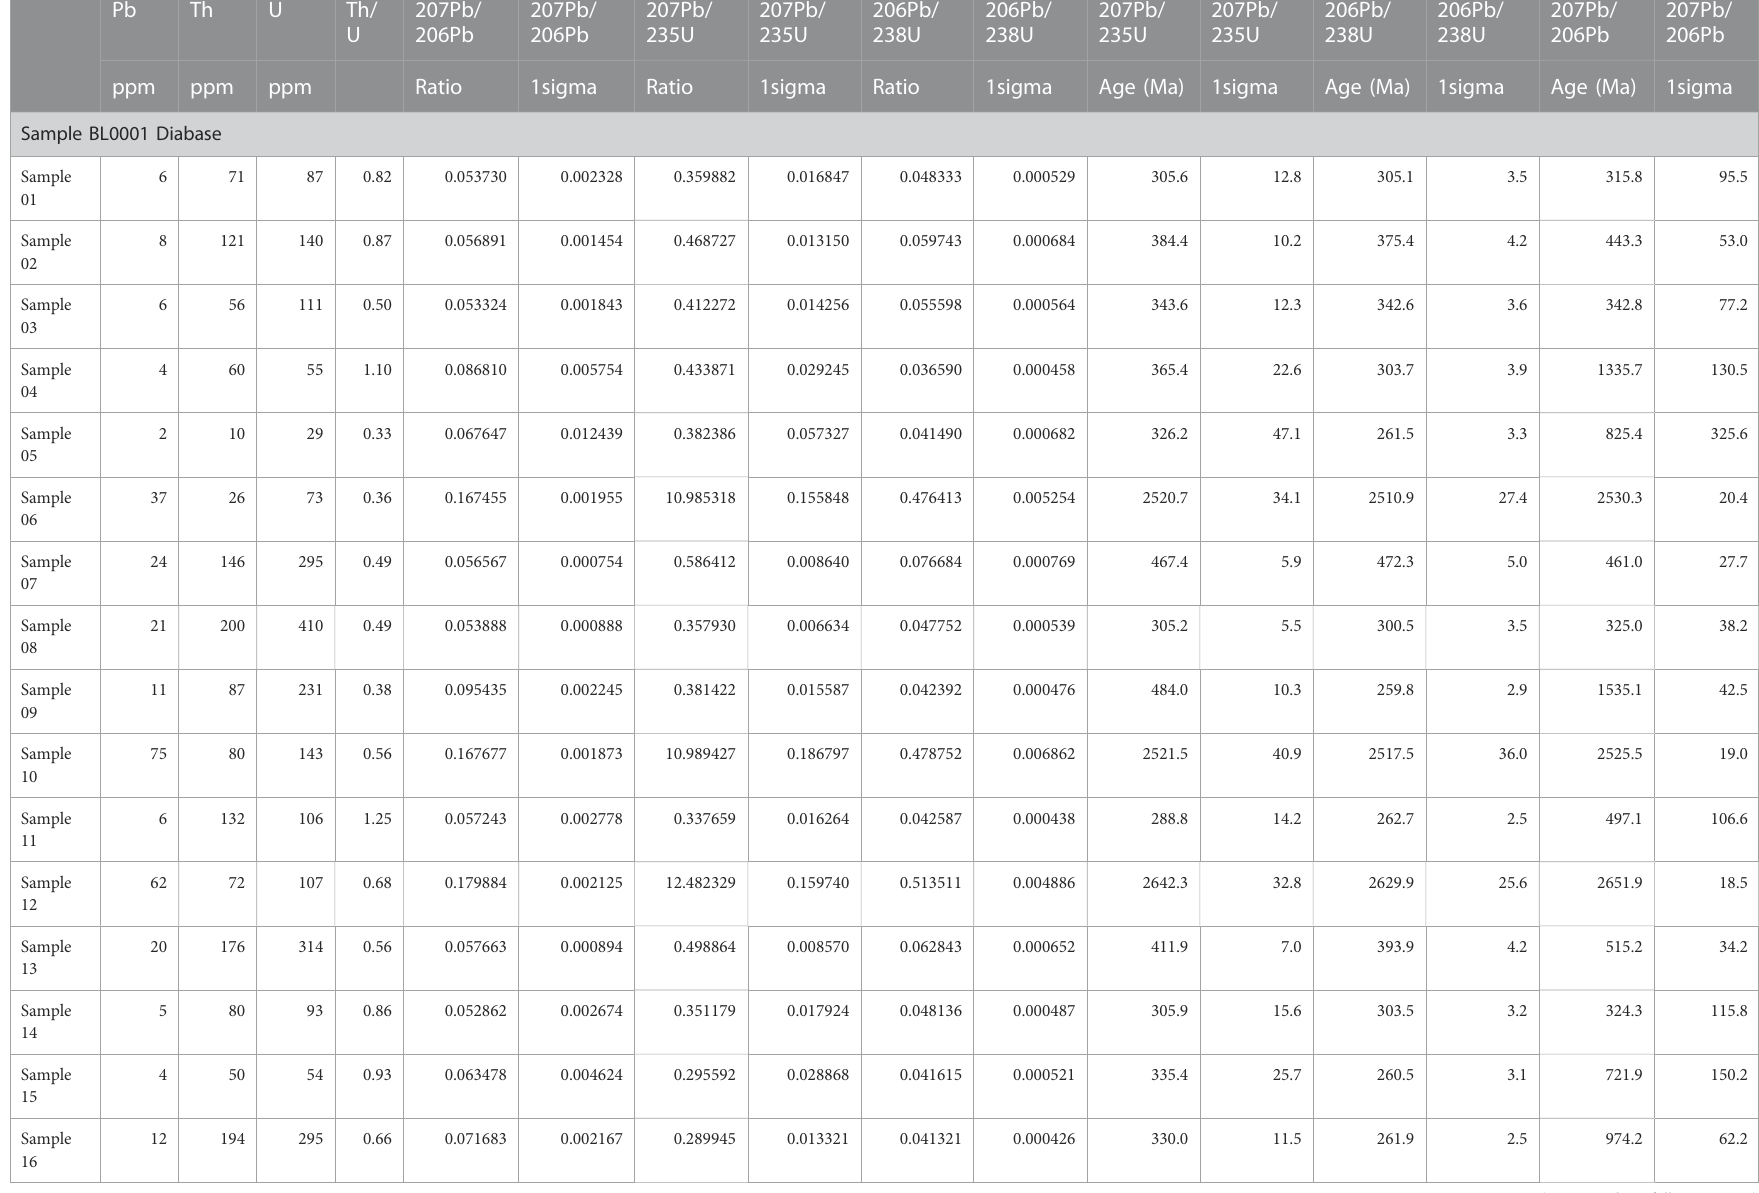
TABLE 1 LA-ICP-MS zircon U-Pb data for the basic igneous rocks in Bairin Right